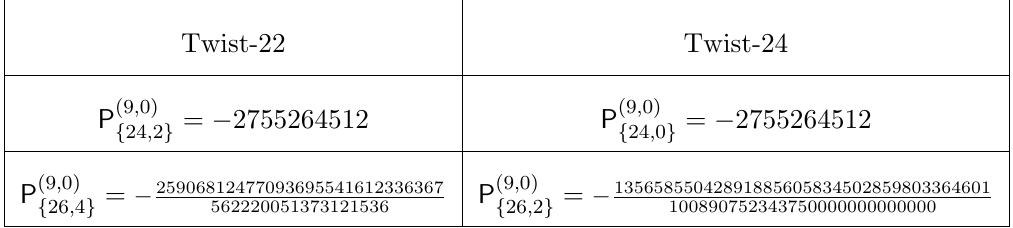
Table 2 . Nine-loop sum rule P (9 ; 0)